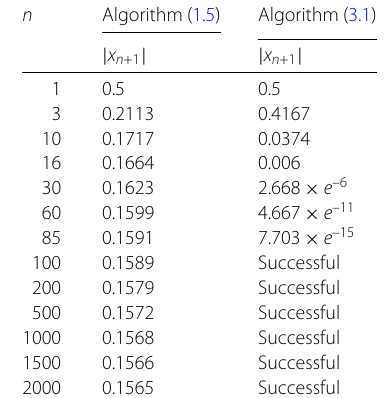
Table 1 Table of values choosing x 0 = x 1 = 0.5 n Algorithm (1.5) Algorithm (3.1)